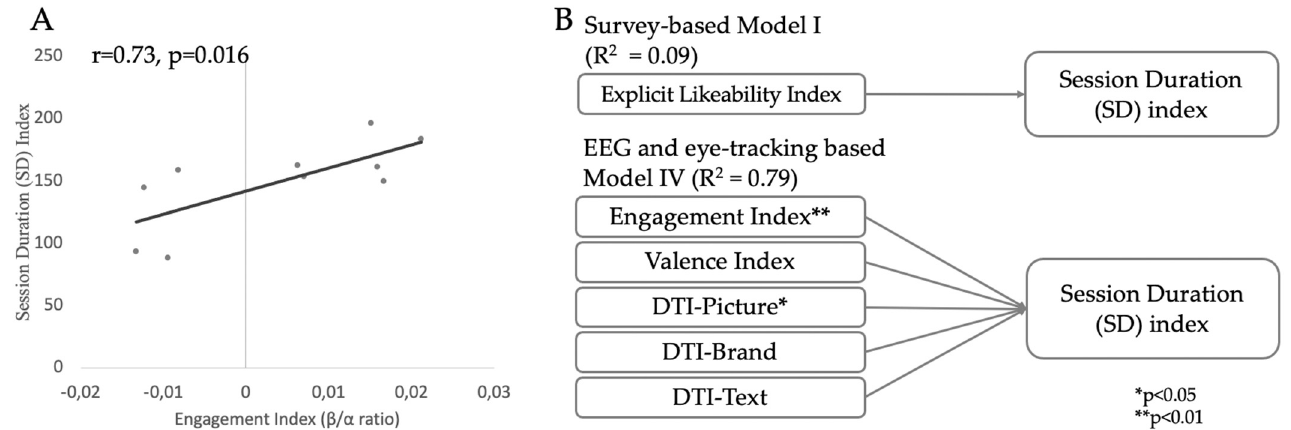
Figure 4. Relationship between population-level effects of banner ads—session duration (SD) index and behavioral likability index, EEG, eye-tracking data. ( A ) The scatterplot indicates the session duration (SD) index as a function of the averaged engagement index ( β / α ratio). The line represents a linear trend estimate. ( B ) The diagrams show key results of linear regression models that estimated whether survey-based explicit likeability index, EEG-based valence and engagement indexes, eye- tracking-based DT picture, DT text, and DT brand indexes were predictive of the session duration index. The adjusted R 2 value is given in parentheses; asterisks indicate significant coefficients (* p < 0.05, ** p <